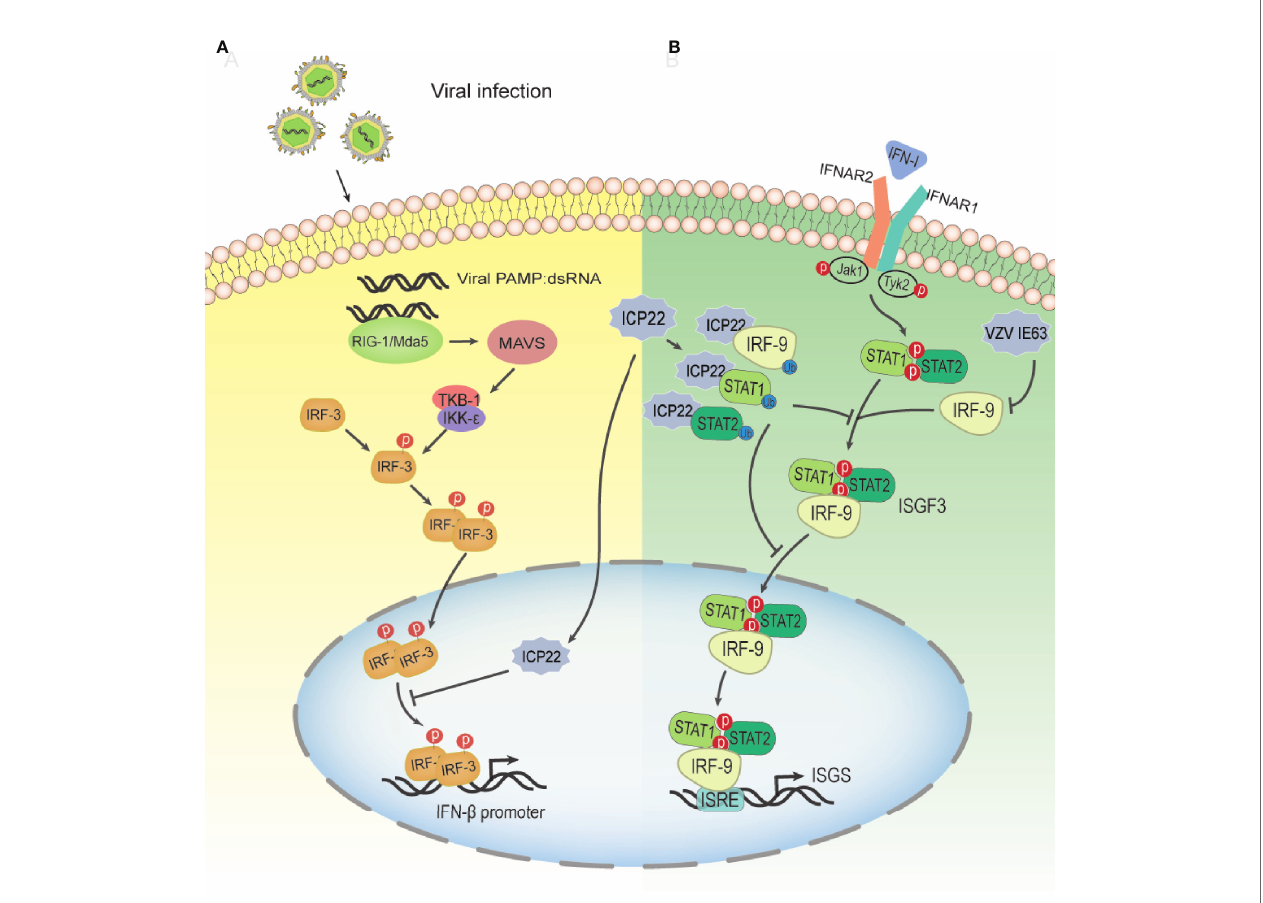
FIGURE 5 | Schematic diagram of HSV-2 ICP22 inhibiting the host type I IFN pathway. (A) The mechanism by which HSV-2 blocks the IRF-3 signal transduction pathway. HSV-2 infection yields a number of byproducts, such as dsRNA, which can be recognized by RIG-I and activate the RIG-I/Mda-5 pathway, thereby promoting IFN- b transcription. Under HSV-2 infection conditions, ICP22 interacts with the DNA binding domain of IRF-3, resulting in the suppression of IRF-3 association with the IFN- b promoter. Ultimately, the production of IFN- b is suppressed by HSV-2, contributing to viral immune evasion(94). (B) The mechanism by which HSV-2 ICP22 blocks the IFN- b -mediated signaling pathway. Type I IFNs are usually expressed at low levels and can be induced by viral infection. After IFN-1 binds to receptors on the cell surface, Jak1 and Tyk2 are activated, leading to tyrosine phosphorylation of STAT1 and STAT2. Phosphorylated STATs dimerize and associate with IRF9 to form ISGF3. ISGF3 translocates to the nucleus and binds to ISRE to activate the transcription of ISG so that the cell is in an antiviral state. After HSV-2 infection, ICP22 induces ubiquitination and degradation of STAT1, STAT2 and IRF9, thereby blocking ISGF3 nuclear translocation. Finally, the production of ISG is inhibited by HSV-2, which promotes the immune escape of HSV-2(100). VZV IE63 interferes with type I IFN-mediated activation of JAK-STAT signaling by degrading IRF9, thereby inhibiting the expression of interferon-stimulated